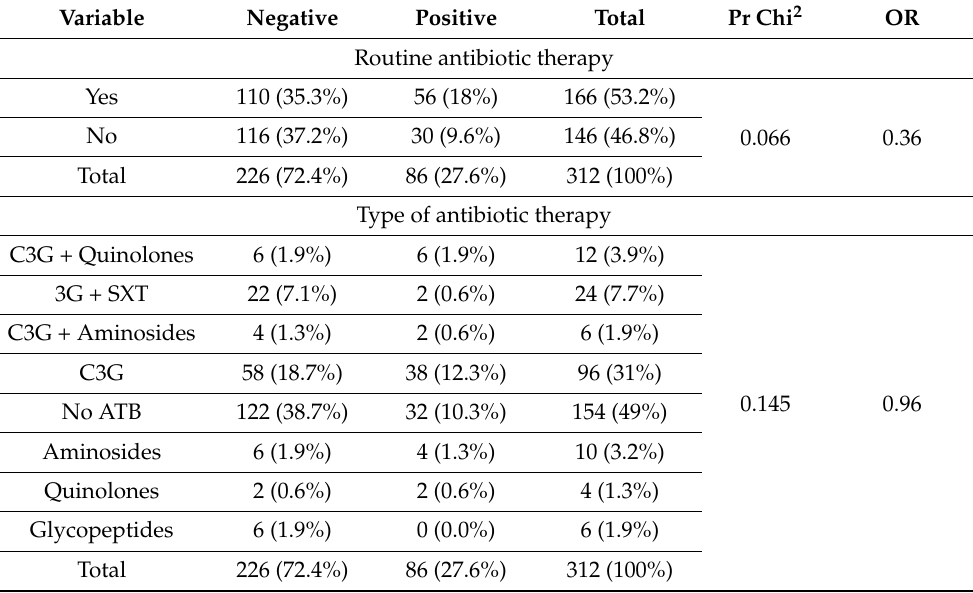
Table 7. Clinical factors linked to the occurrence of urinary tract infections by